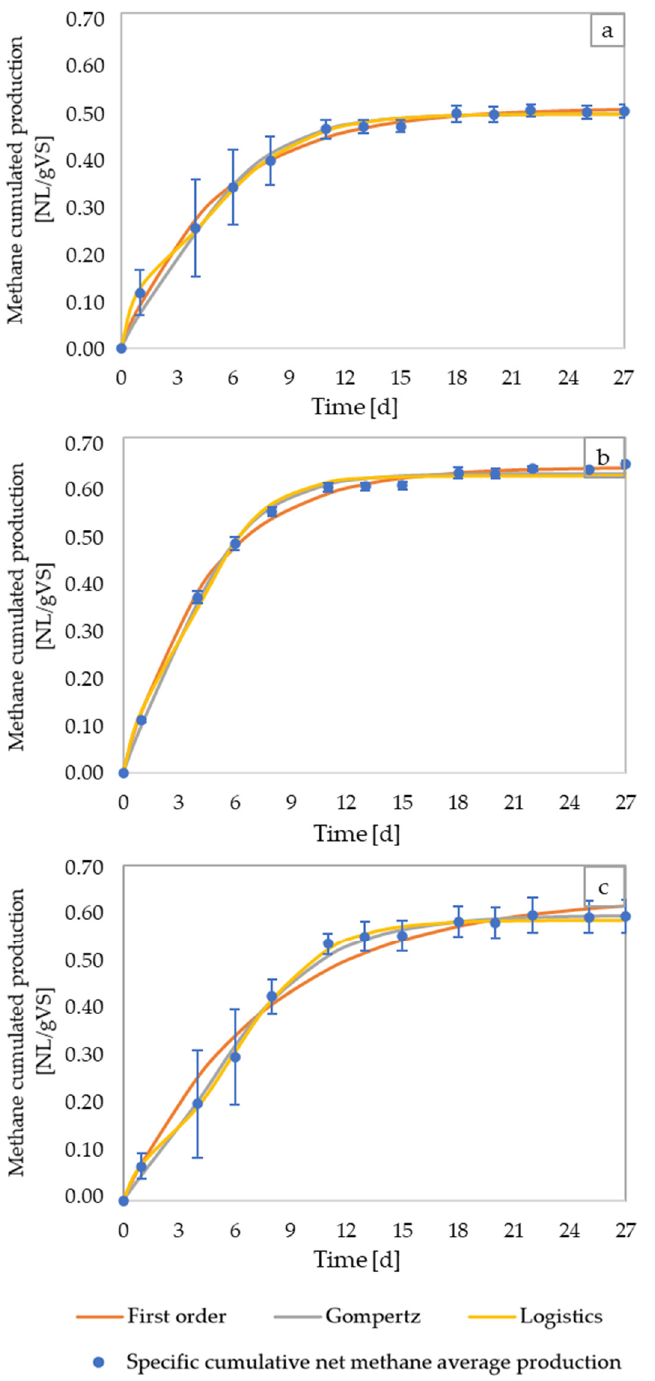
Figure 1. Specific cumulated production of methane measured in the BMP tests and modeled by three prediction models after 2 ( a ), 6 ( b ), and 10 ( c ) days of OFMSW storage.